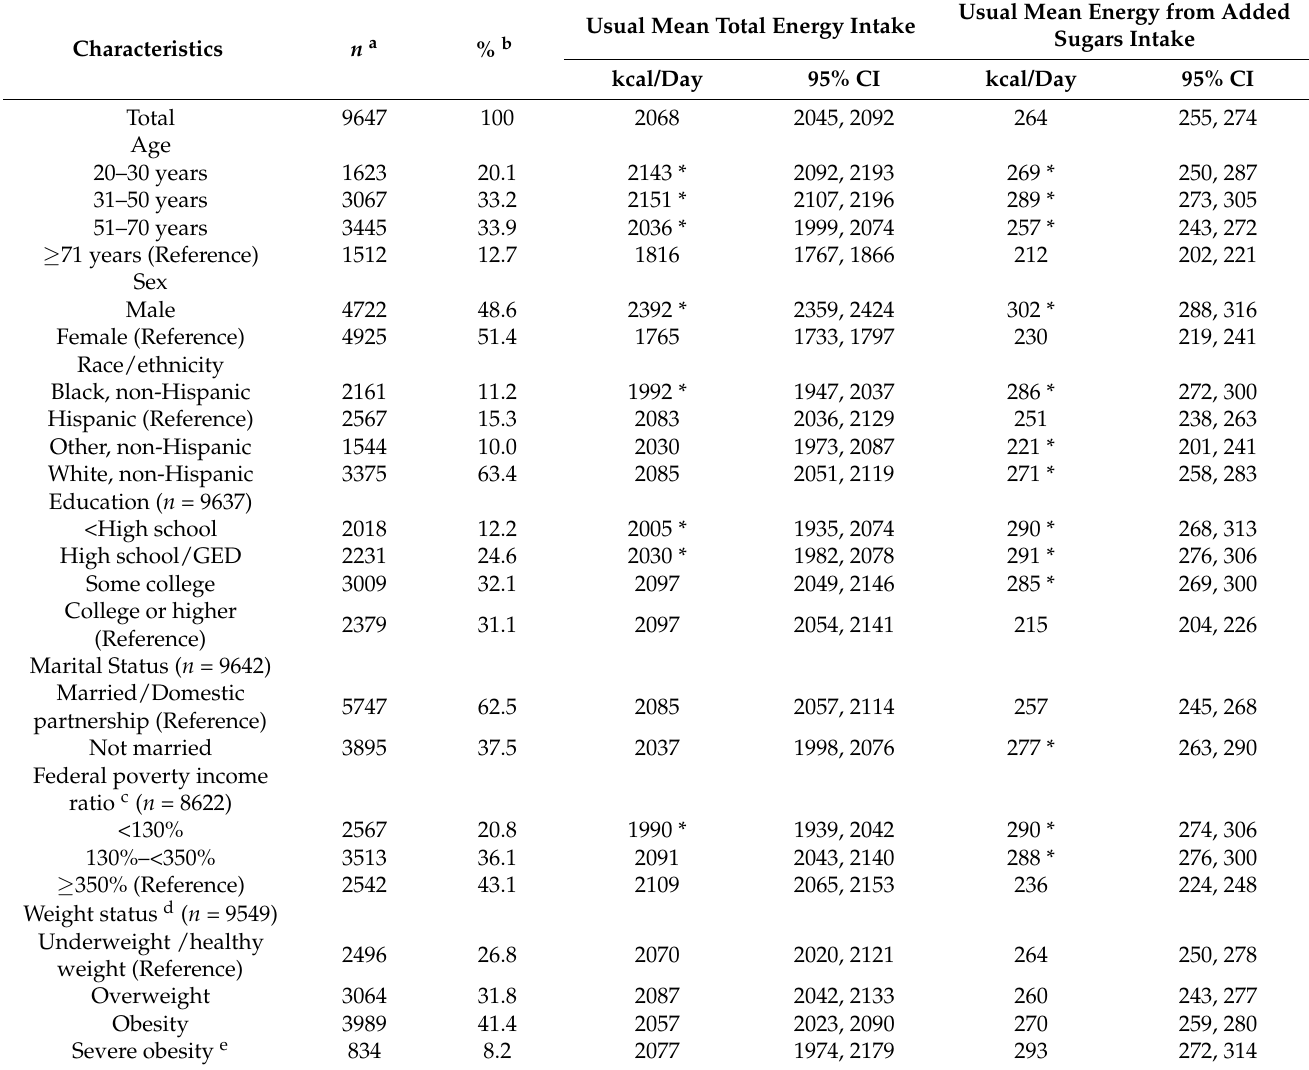
Table 1. Sociodemographic characteristics, usual mean total energy intake, and usual mean